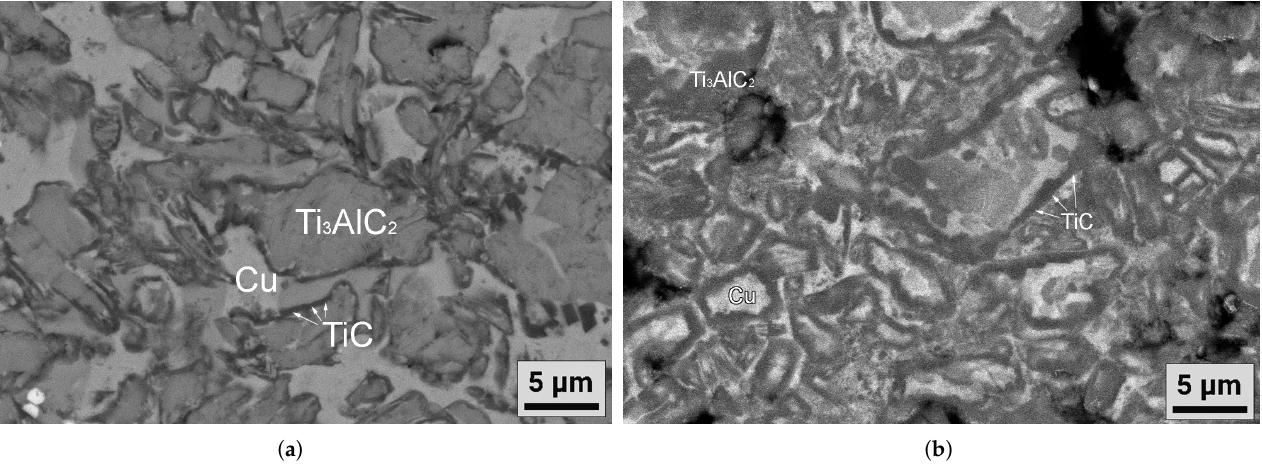
Figure 3. SEM pictures of Ti 3 AlC 2 : Cu (1:1) cross-sections of the samples with nano ( a ) and micro ( b ) copper powder after sintering at 1000 °C in vacuum.